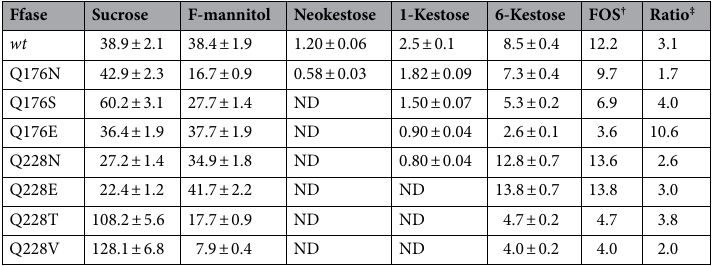
Table 2. Concentration (g l −1 ) of the sugar constituents present at maximum fructosyl-mannitol production in reaction mixtures based on sucrose and mannitol with the referred Ffase variants. † Concentration of FOS: neokestose, 1-kestose, and 6-kestose. ‡ Ratio between fructosyl-mannitol (F-mannitol) and total FOS. ND Not detected. Data represents the average of two independent measurements obtained after 3 h of reaction. Standard deviation values are